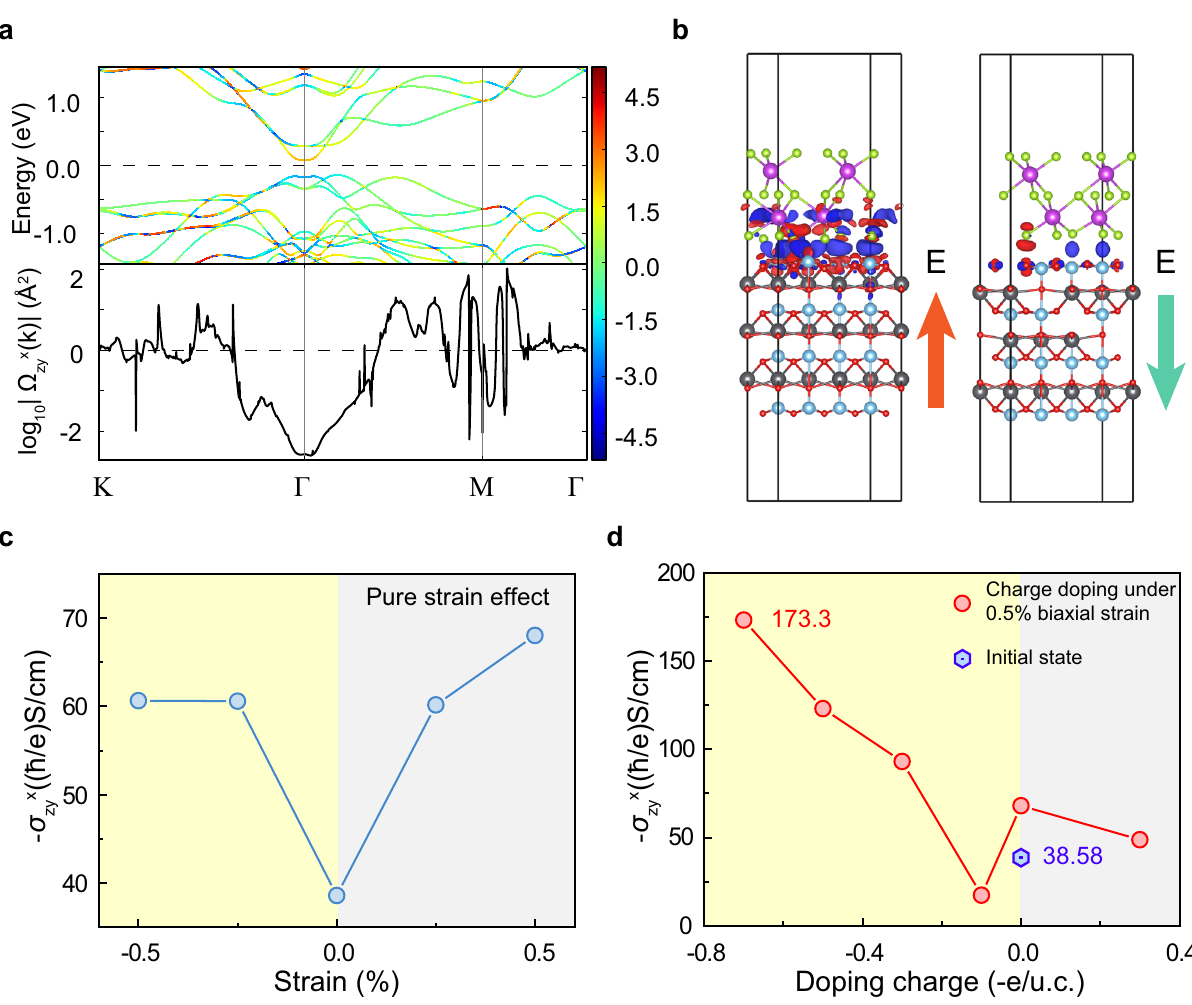
Fig. 5 Spin Hall conductivity calculation for Bi 2 Se 3 structure. a Band structure projected by spin Berry curvature on a log scale (up panel) and the k-resolved spin Berry curvatures (down panel) for the 0.5% biaxial strain bulk Bi 2 Se 3 . b Charge density difference of heterostructure of Bi 2 Se 3 on TiO- terminal PbTiO 3 (001) surface. The picture on the left shows the application of the negative external electric fi eld (along the z direction) on the heterostructure. Simultaneously, the built-in electric fi eld along the − z direction is generated in PbTiO 3 . The polarization of PbTiO 3 is P ↑ . The picture on the right is the opposite. The polarization of PbTiO 3 is P ↓ . The red and blue areas indicate loss and gain electrons, respectively. The Pb, Ti, O, Bi, and Se atoms are depicted by gray, light blue, red, magenta, and green balls, respectively. c SHC as a function of the biaxial strain for bulk Bi 2 Se 3 . d SHC as a function of the charge doping for the bulk Bi 2 Se 3 under 0.5% biaxial strain. The initial state of Bi 2 Se 3 without strain and charge doping is marked with the blue hexagon